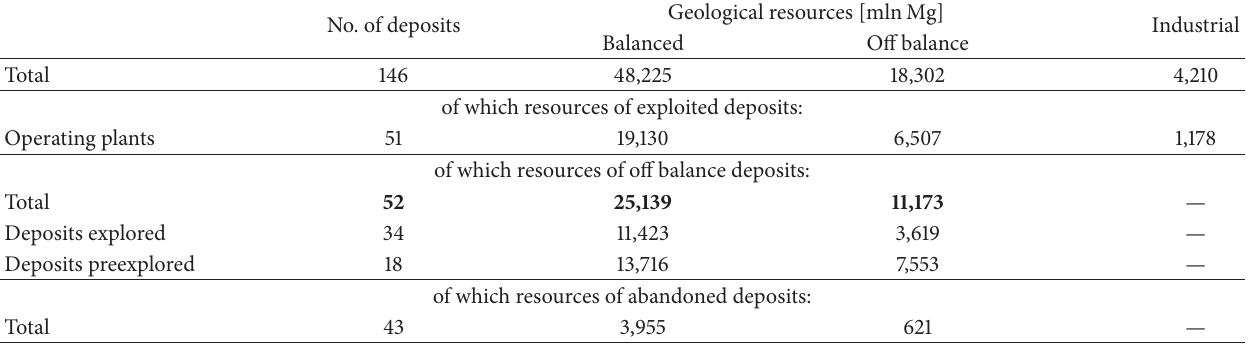
Table 1: Characteristics of hard coal resources in Poland in 2012 [2].